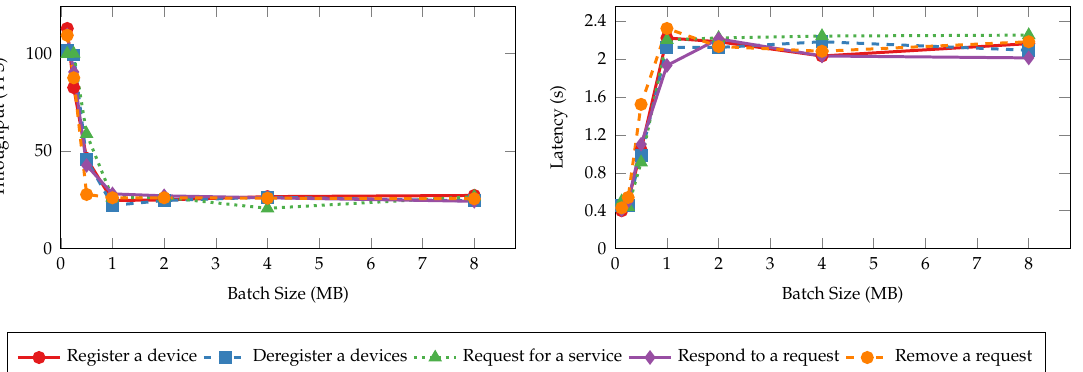
Figure 10. Throughput and latency of transaction operations with varying batch